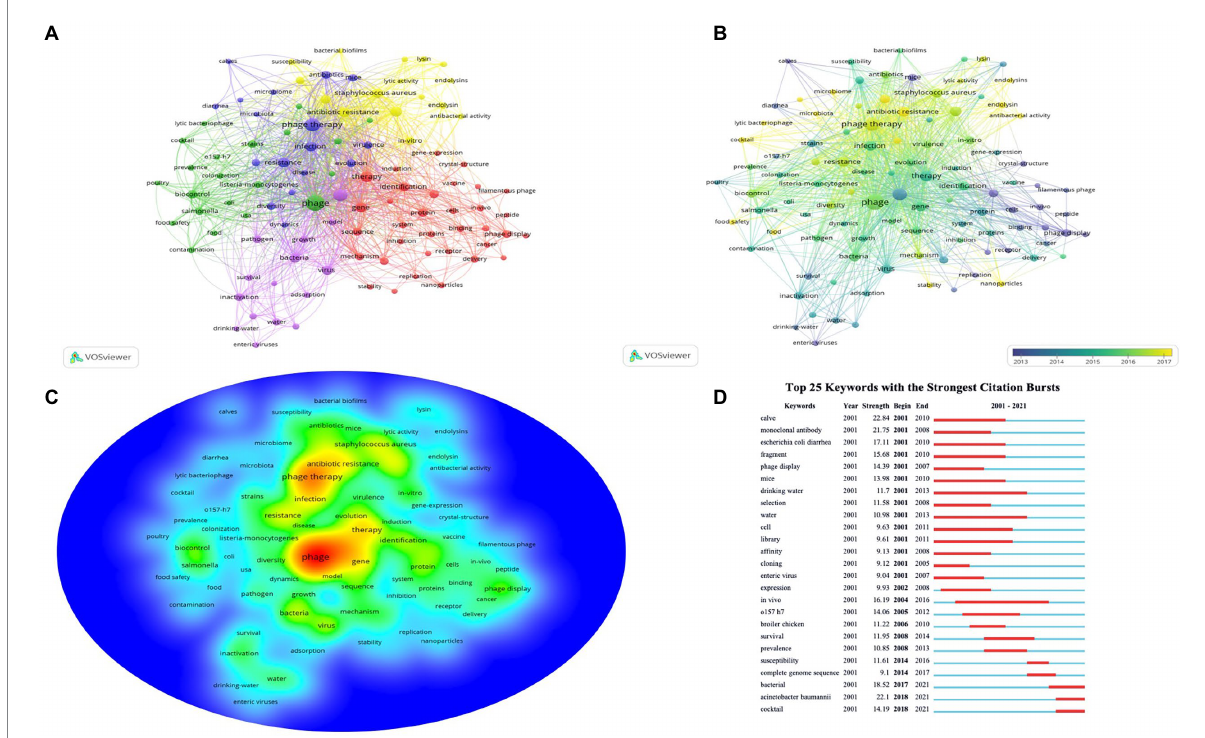
FIGURE 8 The visualization map of keywords. (A) Network visualization of keywords based on VOS viewer. (B) The overlay visualization map of keywords based on VOS viewer. (C) Density visualization map of keyword co-occurrence based on VOS viewer. (D) The top 25 keywords with the strongest citation bursts from 2001 to 2021 based on Cite Space. The red bars represent the strongest citation bursts time